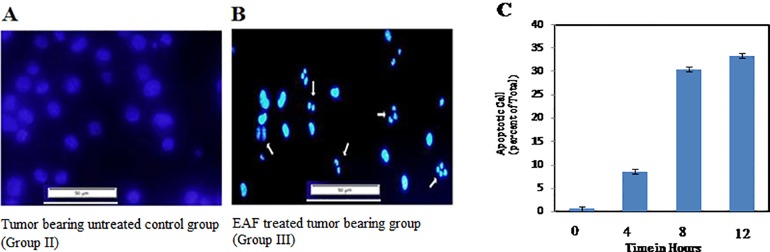
Determination of morphological changes of tumor bearing EAC cells and percentage of apoptosis by fluorescence microscopy and flowcytometry, respectively.(3A) Tumor-bearing untreated control group (Group II) versus (3B) EAF treated, tumor-bearing group (Group III); arrows indicate apoptotic features, including condensed chromatin, apoptotic bodies, plasma membrane blebbing, and nuclear fragmentation. (3C) EAC cells were treated with EAF in vitro for different time intervals and percentage of apoptotic cells of total cells was analyzed by flow cytometry. Data are shown as means of 3 independent experiments (n = 3).